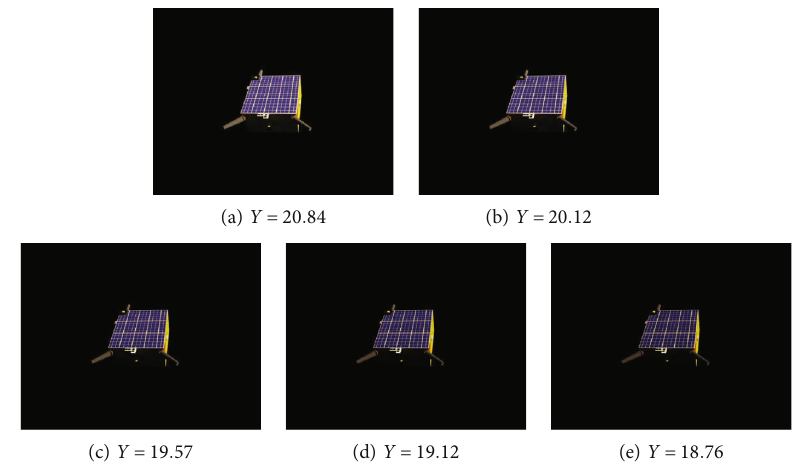
Figure 14: Fused images with di ff erent illumination conditions.